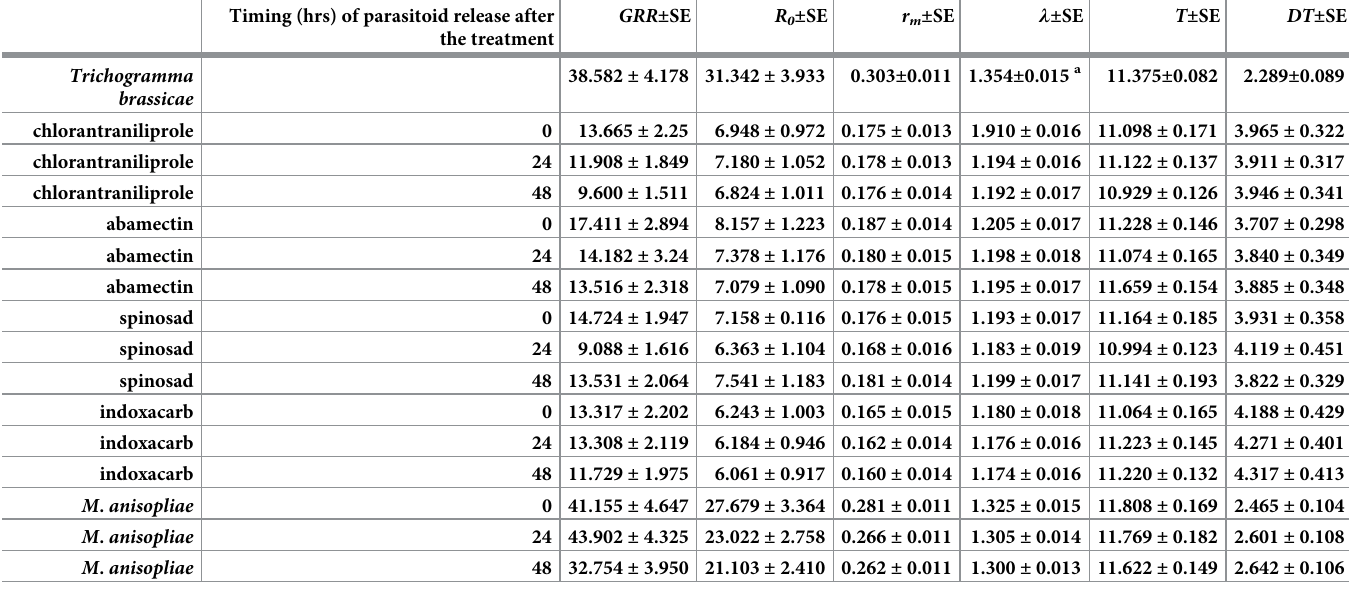
Table 2. Life table parameters (means ± SE) estimated for Trichogramma brassicae developed on Tuta absoluta eggs sprayed with a low lethal concentration of 25% at three-time intervals. Timing (hrs) of parasitoid release after GRR ± SE R 0 ± the treatment